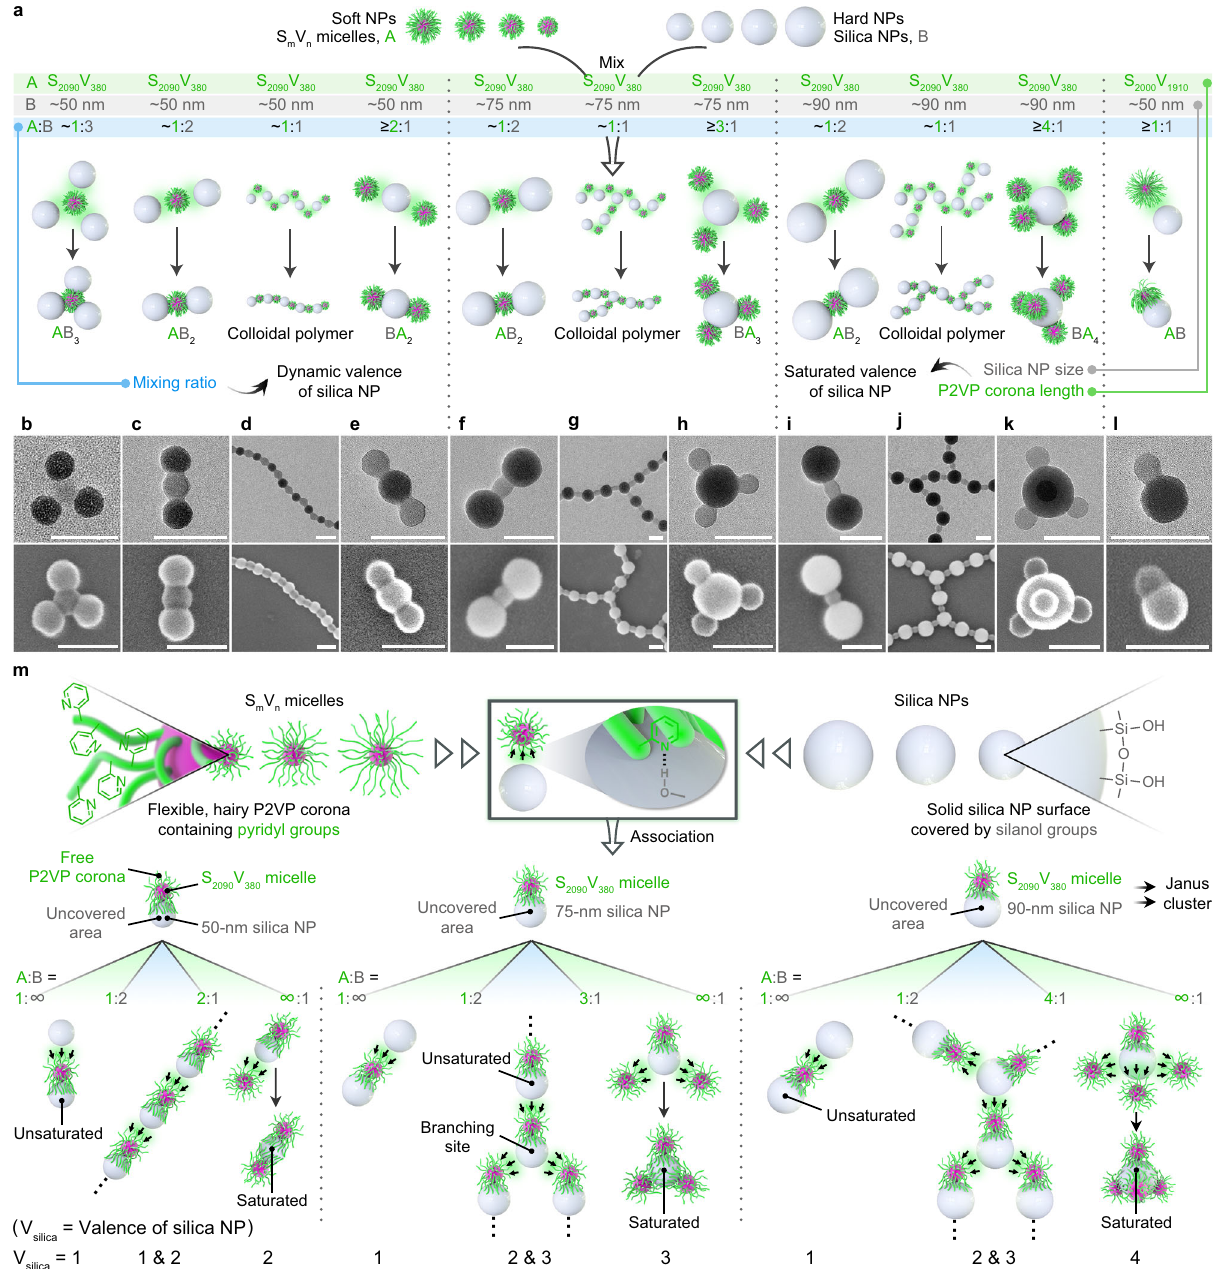
Fig. 2 Primary co-assembly of SV micelles and silica NPs in tunable valences. The valence of the co-assembled structure can be precisely regulated by the relative size and feeding ratio of SV micelles and silica NPs. a Schematic illustration and b – l corresponding transmission electron microscopy (TEM) and scanning electron microscopy (SEM) images for typical colloidal architectures formed by diverse combinations of S m V n micelles (S m V n = PS m - b - P2VP n , denoted as A) and silica NPs (denoted as B) in different A:B feeding ratios. m Schematic illustration for the association process of S 2090 V 380 micelles and 50-nm/75-nm/90-nm silica NPs, which probably involves the formation of an intermediate Janus cluster once a S 2090 V 380 micelle binds to a silica NP and the subsequent association at the SV micelle pole and/or the silica NP pole. The relative size determines the area a micelle can cover on a silica NP surface, and the feeding ratio regulates the arrangement between micelles and silica NPs. The PS core-forming and the P2VP corona-forming blocks are indicated by pink and green colors, respectively. The valence of silica NP (V silica ) means the number of surrounding, actually associated soft NPs. Scale bars = 100 (Supplementary Figs. 13 and 19). At a higher A:B ratio (3:2 for of the silica NP and the relatively fl exible and reversible 75-nm silica NPs and 2:1 for 90-nm silica NPs), the Janus interactions between the soft and hard NPs also facilitate the intermediates and the remaining micelles were linked into construction of various dynamically-trapped colloidal architec- relatively extended 2D networks (Supplementary Fig. 14) and tures. For example, at A:B ≈ 1:1, the higher-valence silica NP large-scale 3D stacked monoliths (Supplementary Fig. 20). Such poles allowed the association with more than one SV micelles, dynamic valence is predominantly regulated by the A:B feeding leading to the formation of highly branched colloidal chains